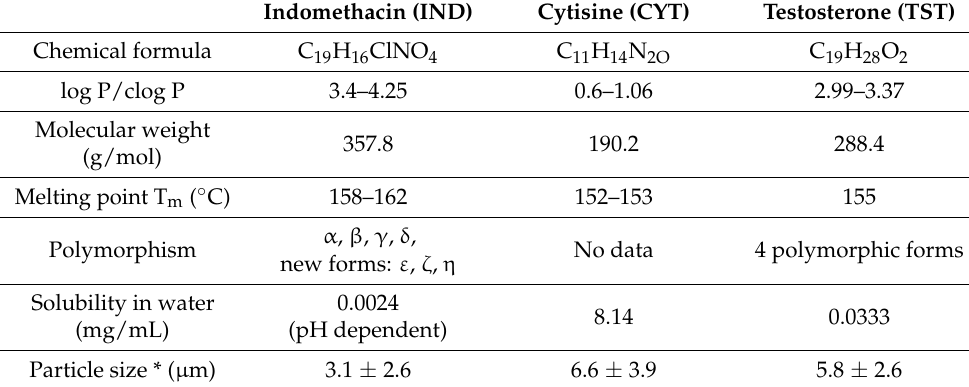
Table 2. Characteristics of the investigated drug substances (APIs)